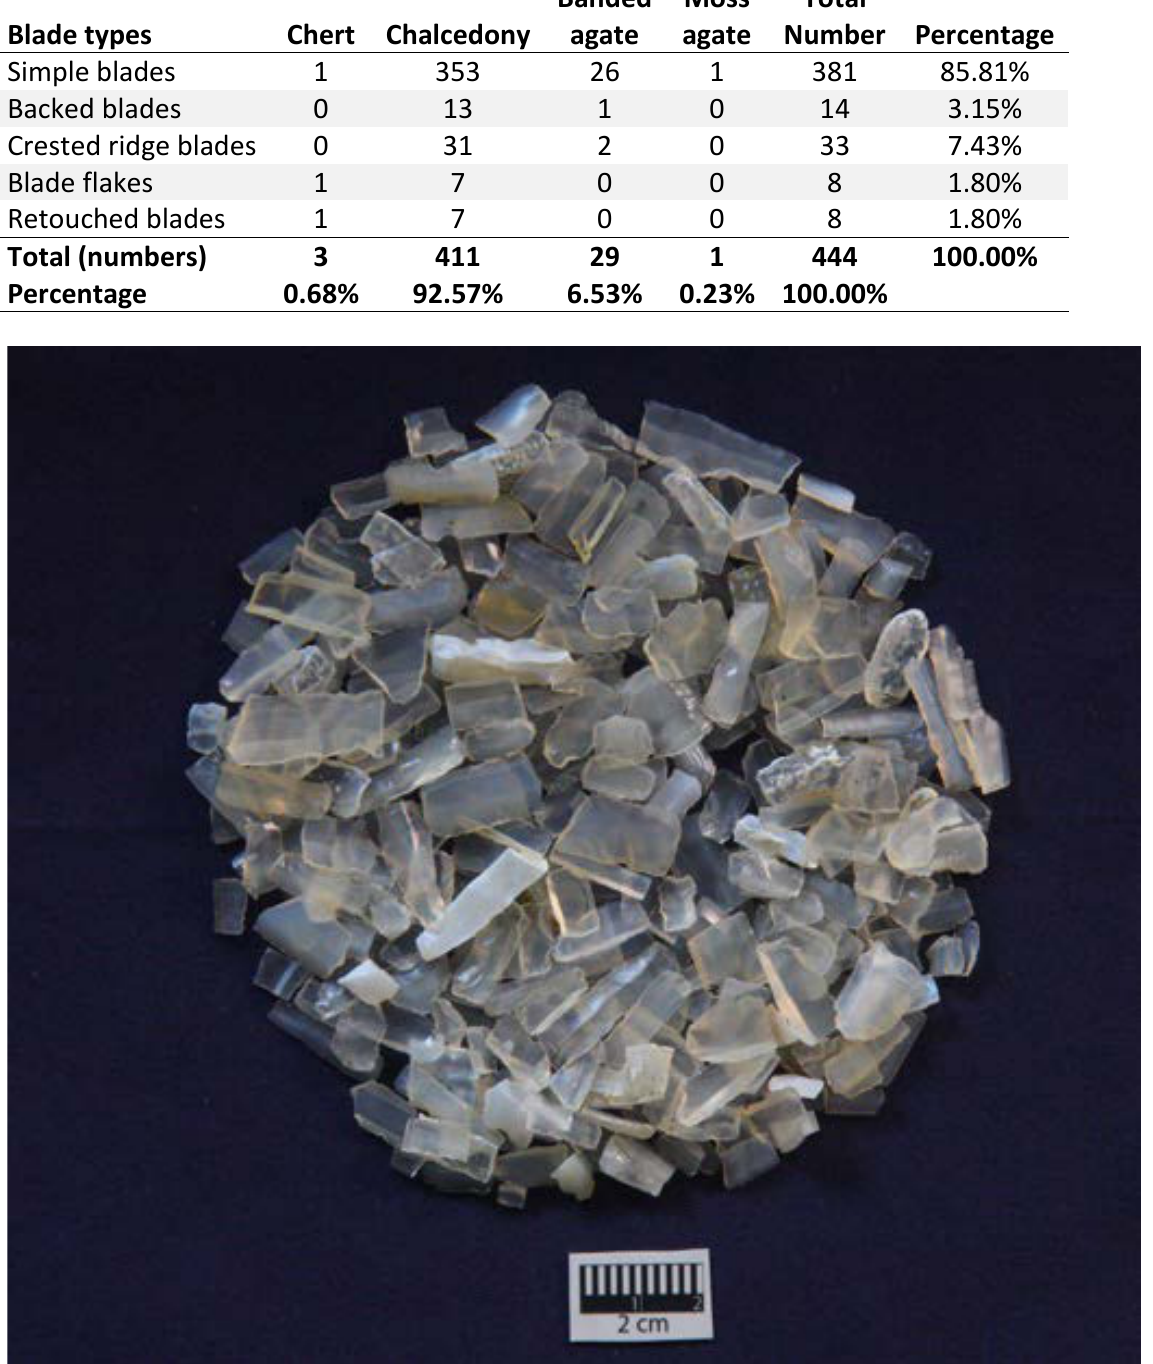
Figure 3: Various types of blades made out of Chalcedony (P.C. Department of Archaeology, University of